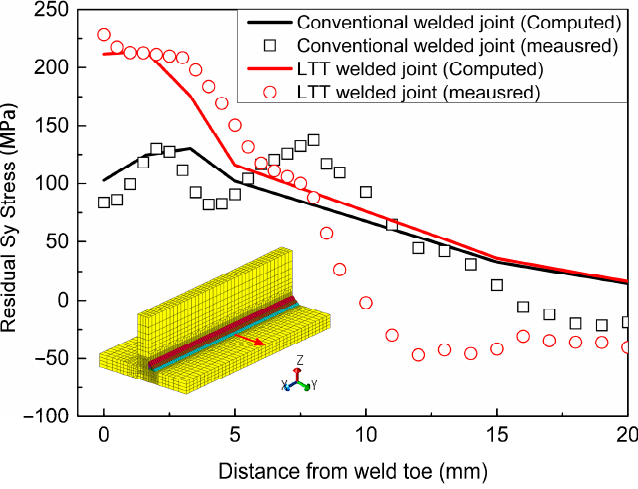
Figure 11. Computed residual Sy stress versus the experimental result.